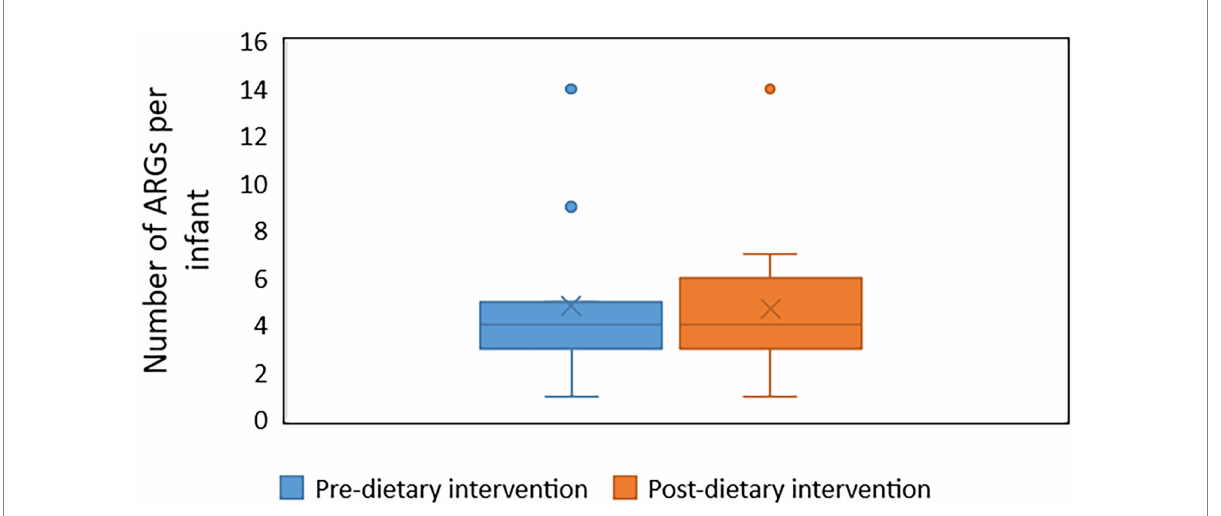
FIGURE 13 The number of antibiotic resistance genes (ARGs) in infant stool samples collected pre-and post-dietary intervention. X represents the mean value.